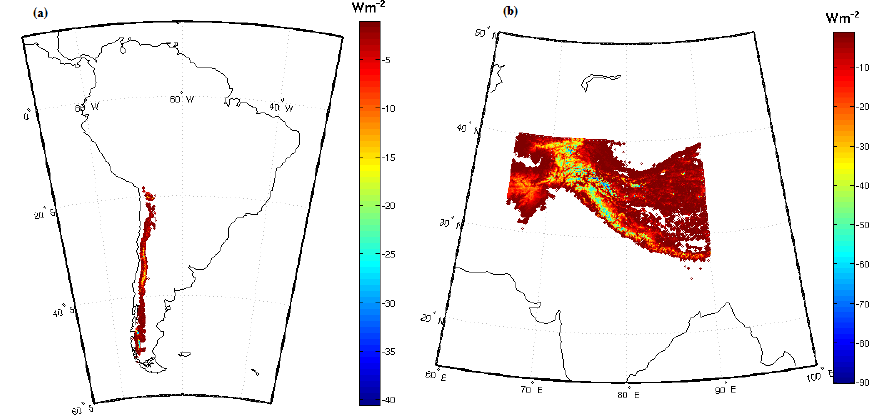
Figure 6. Maps showing all-sky LCrRE, averaged over 2001–2013 over the (a) Andes and (b) Himalayan mountain ranges. Table 2. All-sky (clear-sky) CrRE (Wm − 2 ) derived with different algorithms. All cases apply the CAM4 radiative kernels. Both flags Only NISE Both flags Only NISE with original flag with with land flag with climatology original land class climatology climatology climatology